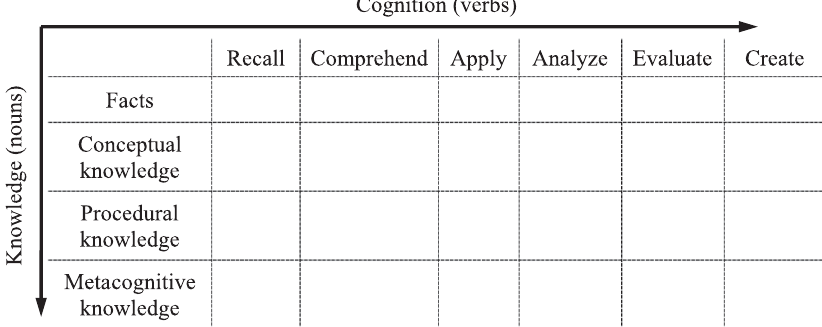
FIG. 1. Two-dimensional Bloom ’ s taxonomy. The vertical dimension contains knowledge types (represented by nouns); the horizontal dimension contains cognition processes (represented by